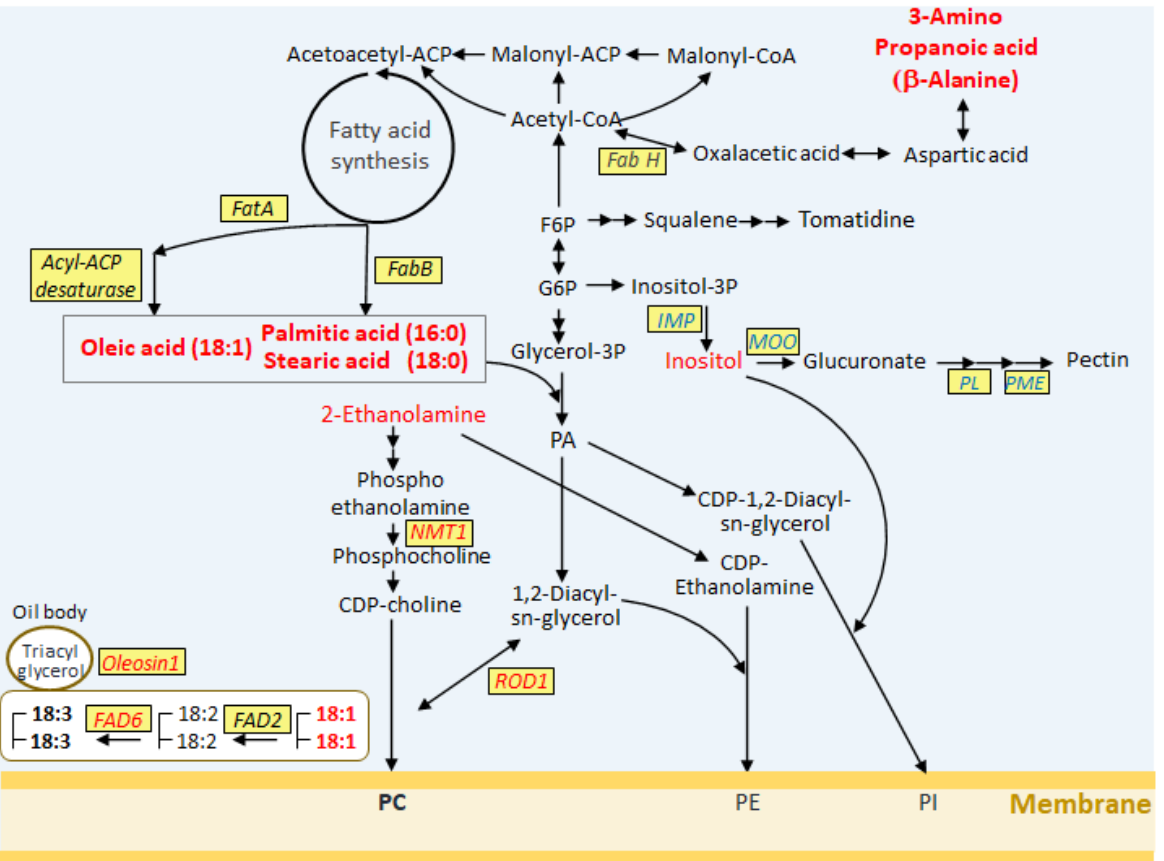
Figure 4. Model of the metabolic pathways in tomato fruits under drought stress. Genes or components upregulated or downregulated by drought-stressed conditions are shown in red and blue, respectively. The enzyme-encoding genes that were extracted as differentially expressed genes (DEGs) based on enrichment analysis of microarray data are shown in italics. The metabolites identified as accumulating by MSI are marked by bold font. The reaction in the white box shows desaturation of the PC constituent fatty acids in the ER. G6P, Gluctose-6-phosphate; F6P, Fluctose-6-phosphate; PA, phosphatidic acid; FabB, 3-oxoacyl-(acyl-carrier-protein) synthase I, chloroplastic; FabH, 3-oxoacyl-ACP synthase3; FatA, oleoyl-acyl carrier protein thioesterase, chloroplastic; NM,; phosphoethanolamine N-methyltransferase; ROD1, phosphatidylcholine:diacylglycerolcholine phosphotransferase 1; IMP, inositol monophosphatase; MOO, inositol oxygenase; PME, pectin esterase; PL, pectate lyase; FAD2, delta-12 fatty acid desaturase; FAD6, omega-6 fatty acid desaturase.